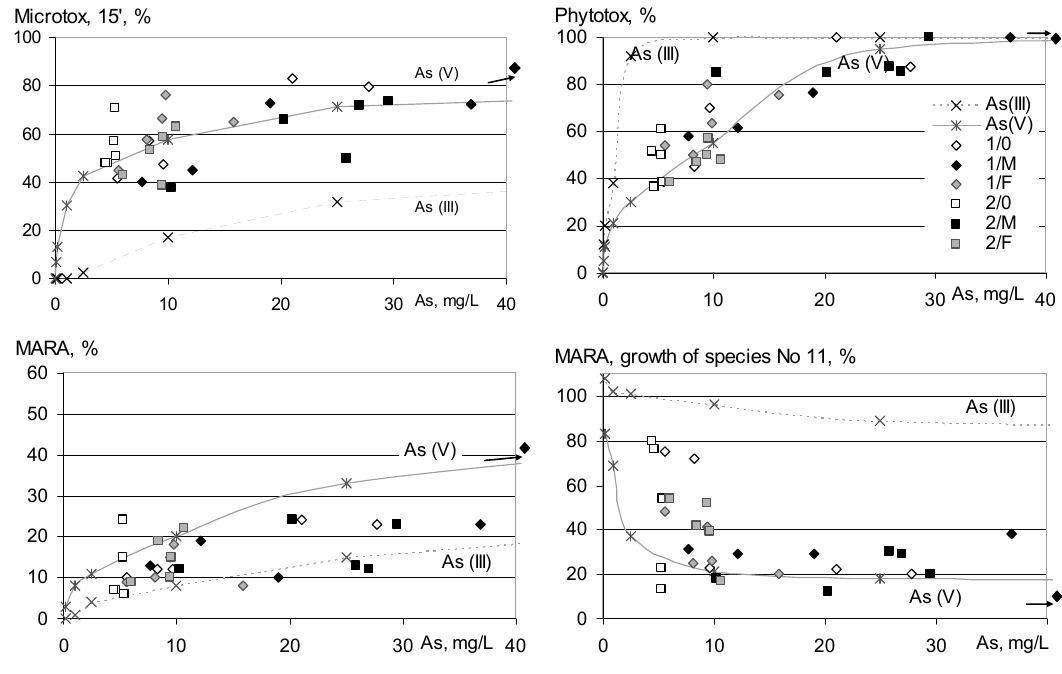
Figure 3. Results of bioassays related to the concentrations of As in soil pore water. The data obtained for two soils (1 and 2), all treatments (0, M, F), and five incubation times. The curves illustrate control results obtained for standard solutions of As(III) and As(V). All data are the means of three replicates.